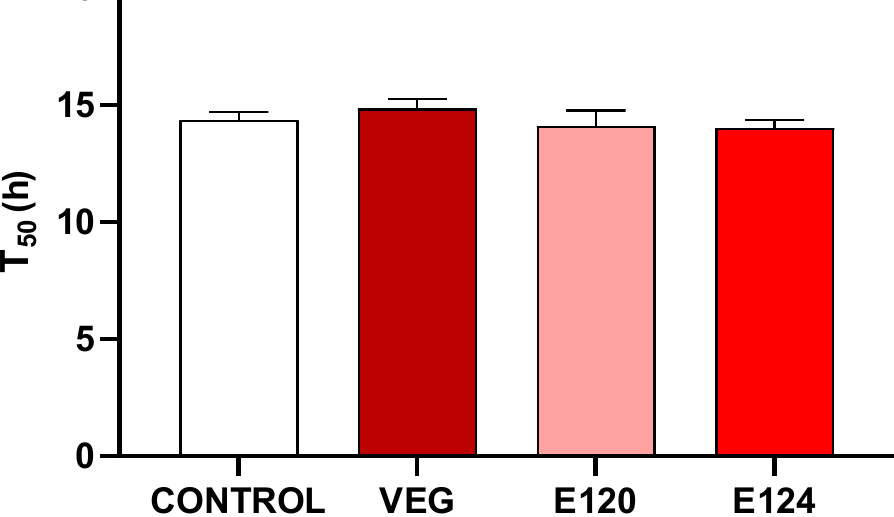
Figure 4. Naupliar stages (%) in Artemia salina samples exposed to vegan red VEG, E120, or E124. Five days from hatching. VEG delays (increased percentage of L3 nauplii; *) and E124 and E120 accelerate (appearance of L5 nauplii; *) development. Ten days from hatching. Moderate and significant acceleration of development in VEG and E120 (presence of L7 and L7 and L8 nauplii respectively; *). In E124, are present only L3 and L4 nauplii.